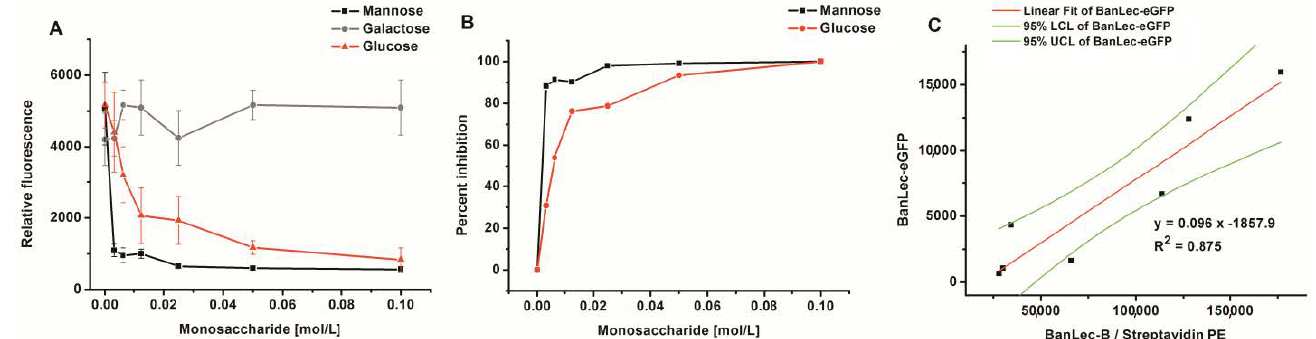
Figure 4. Inhibition of BanLec-eGFP binding to Salmonella enterica , subspecies enterica serovar Typhimurium isolate 2865 with different amounts of monosaccharides; panels ( A , B ) and correlation of staining with BanLec-eGFP with the staining with BanLec-biotin (BanLec-B) and streptavidin-phycoerythrin (PE)—panel ( C ), using flow cytometry. Each point was run in quadruplicate. Panel: ( A ) relative fluorescence; ( B ) percentage of inhibition; ( C ) correlation. For correlation experiments, 4 µ g of BanLec-eGFP was used and 0.5 µ g of BanLec-B with 0.2 µ g streptavidin-PE (eBioscience) was used. LCL, lower confidence limit; UCL, upper confidence limit.